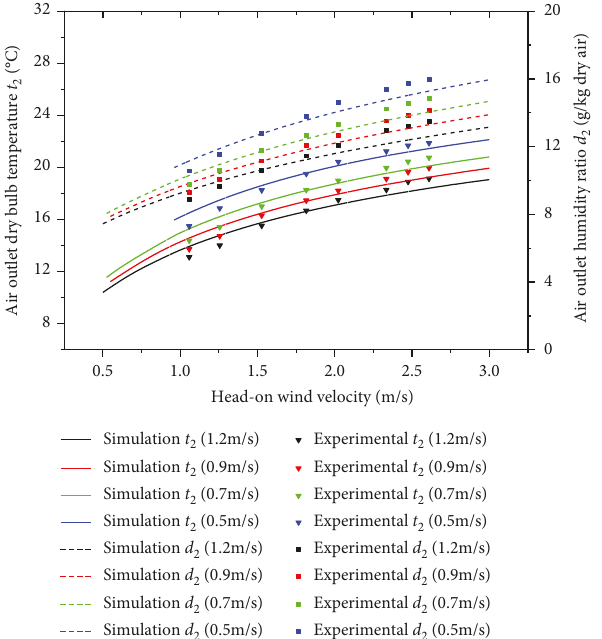
Figure 7: Effects of the head-on wind velocity and water flow velocity to air outlet parameters.